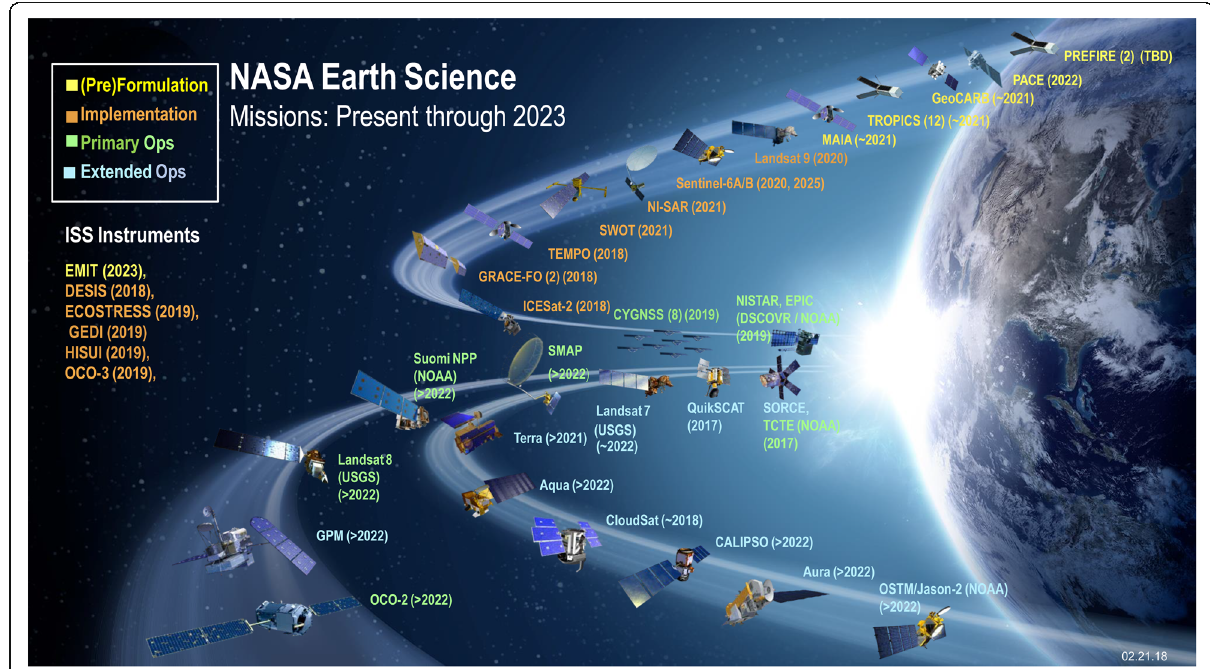
Fig. 3 NASA ’ s active Earth science satellite missions in 2019, including those on the International Space Station (modified from www.eospso.nasa. gov). NASA's full Earth Observation fleet includes instruments measuring ocean, land, and atmospheric chemistry, processes and